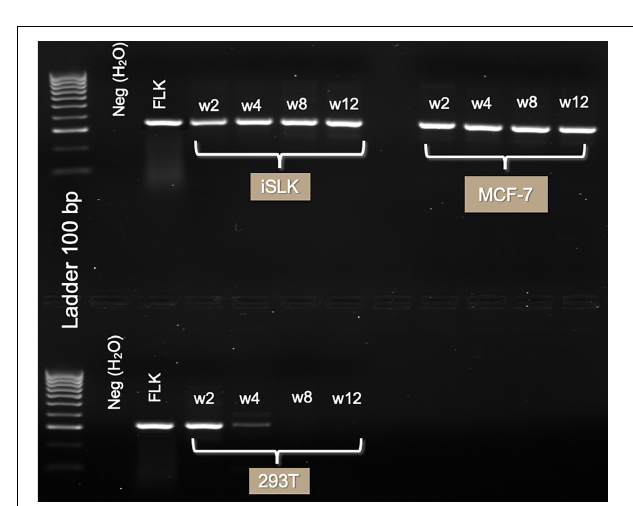
FIGURE 2 | Three-month follow-up of BLV infection in human cell lines with GRE region. Gel electrophoresis of PCR product (285 bp) run on 1.5% agarose TBE gel, stained with ethidium bromide. Lanes in order are of DNA extracted 2 weeks, 1 month, 2 months, and 3 months after TransWell infection. Notice the high intensity of the bands on iSLK and MCF-7 cell lines. In 293T cell line, viral infection was lost after week 4 post-infection.